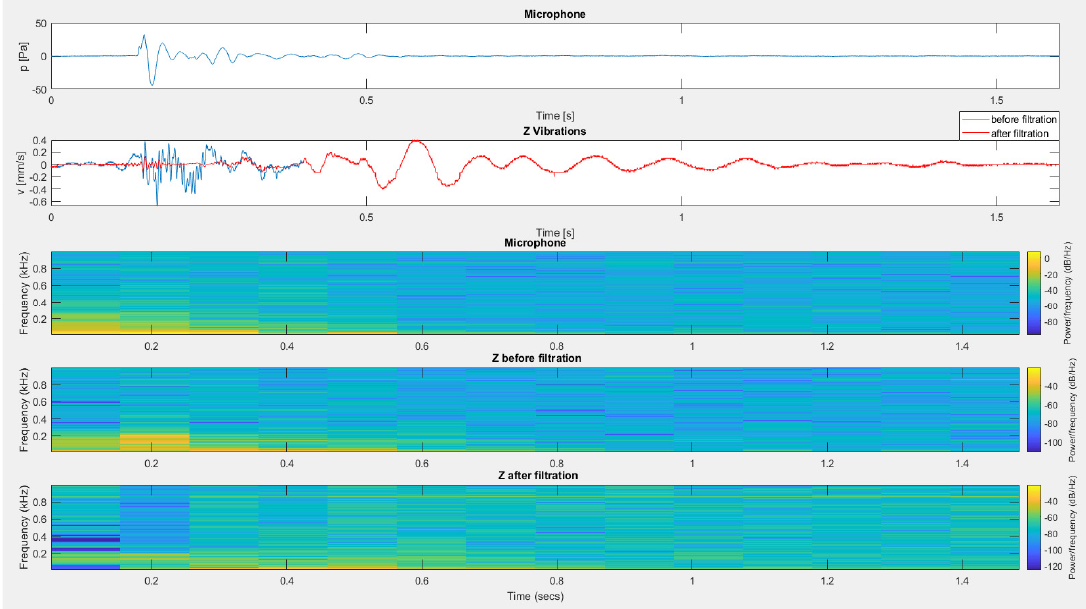
Figure 19. The result of using filtration for the vertical component from a sensor located outside the building—detonation of dynamite material placed in a short blast hole.